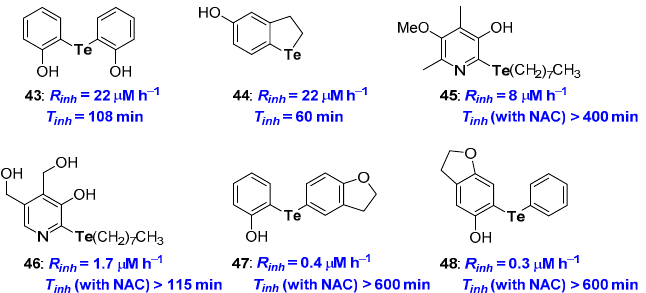
Figure 13. A selection of potent Tellurium containing phenolic antioxidants prepared so far.